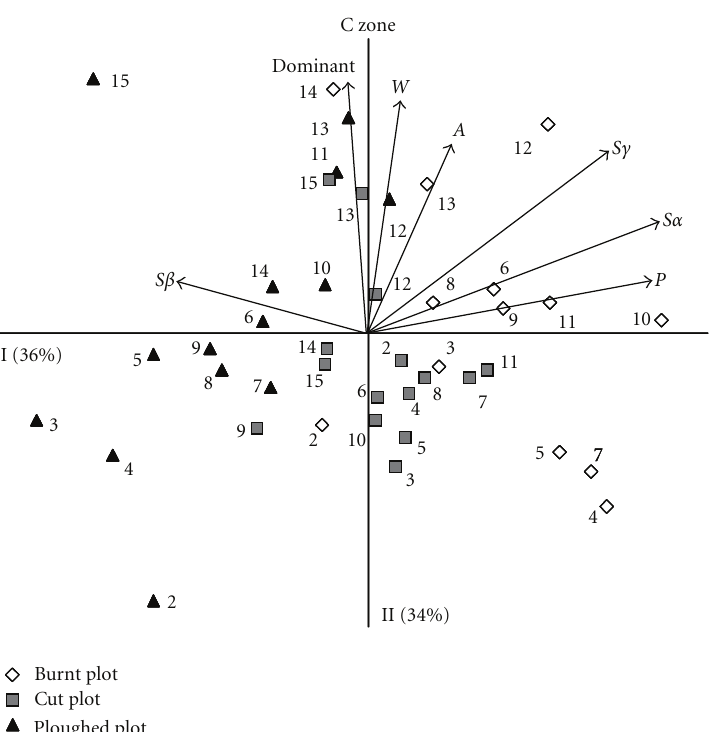
Figure 5: Location of variables and samples in the plane defined by the two first axes of the principal components analysis carried out with data from the three plots in zone C. (Annual herbaceous species number ( A ), perennial herbaceous species number ( P ), woody species number ( W ), S α , S γ , S β , and cover of dominant species (Dom.).) Numbers after symbols representing years after experimental disturbances.